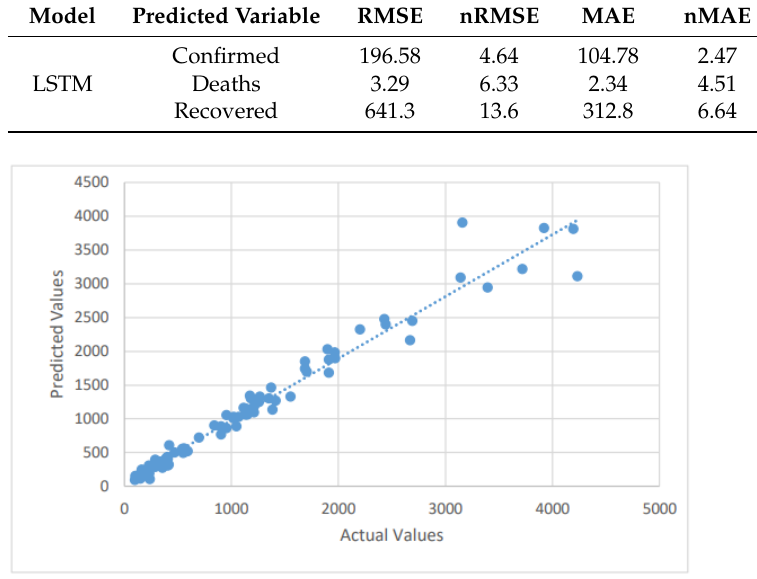
Figure 2. A scatter plot of the confirmed cases by the LSTM on the testing dataset.